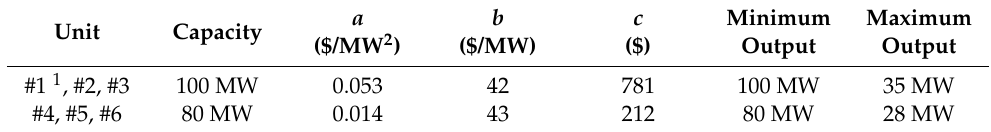
Table A1. Parameters of thermal